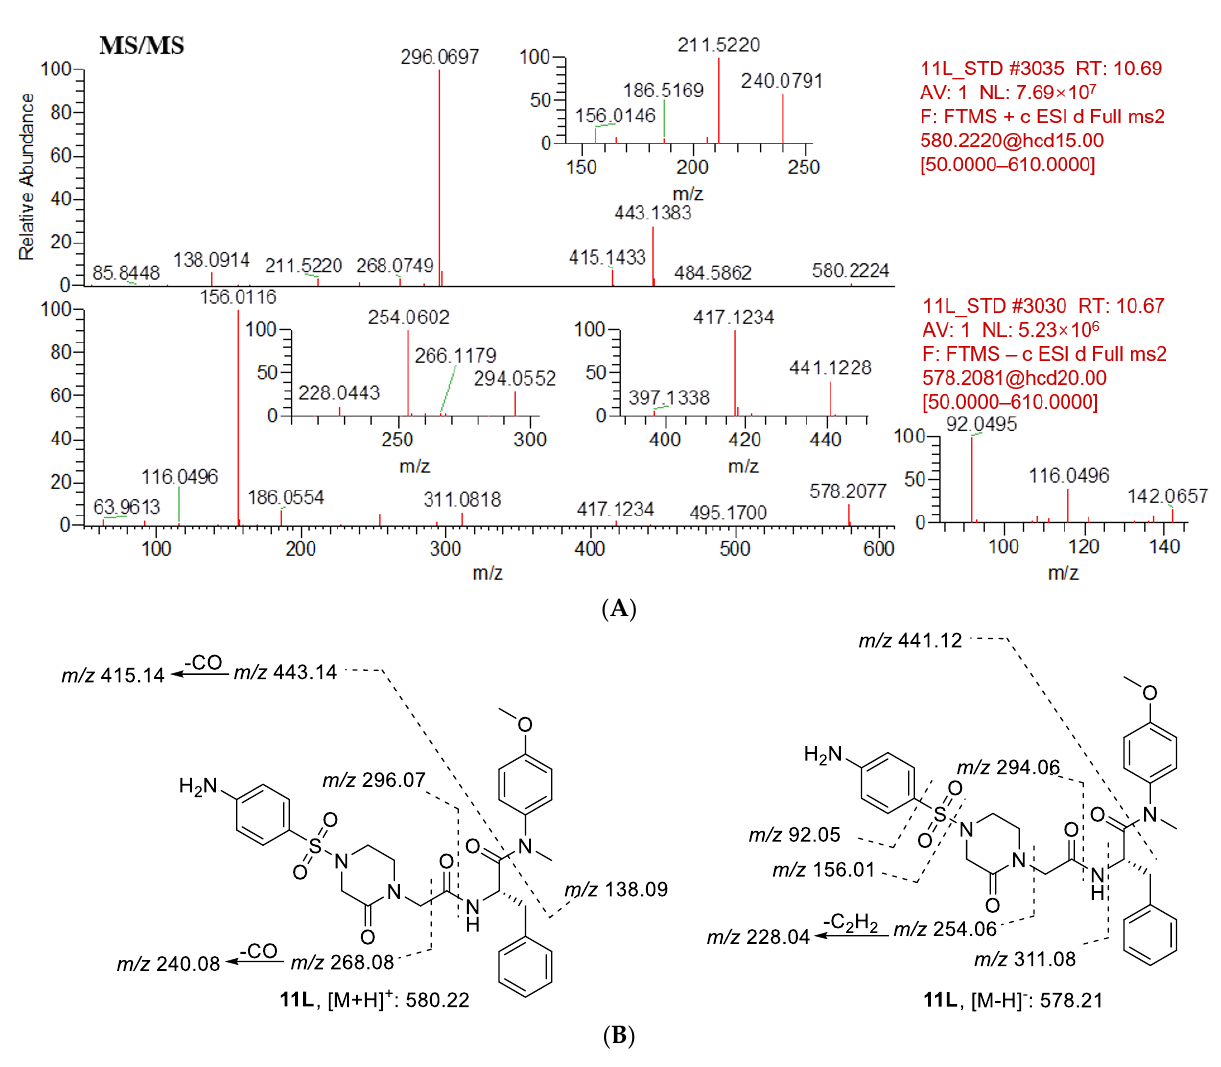
Figure 8. ( A ) CID mass spectrometry of 11L ; ( B ) analysis of mass spectrometry fragments (positive ion, m / z 580.2224; negative ion, m / z 578.2077). The major fragment ions of 11L without metabolism are positive ions at m / z 443.1384, 296.0697, 268.0749, 138.0914, and negative ions at m / z 441.1228, 311.0818, 294.0552, 254.0602, 156.0116, 92.0495.